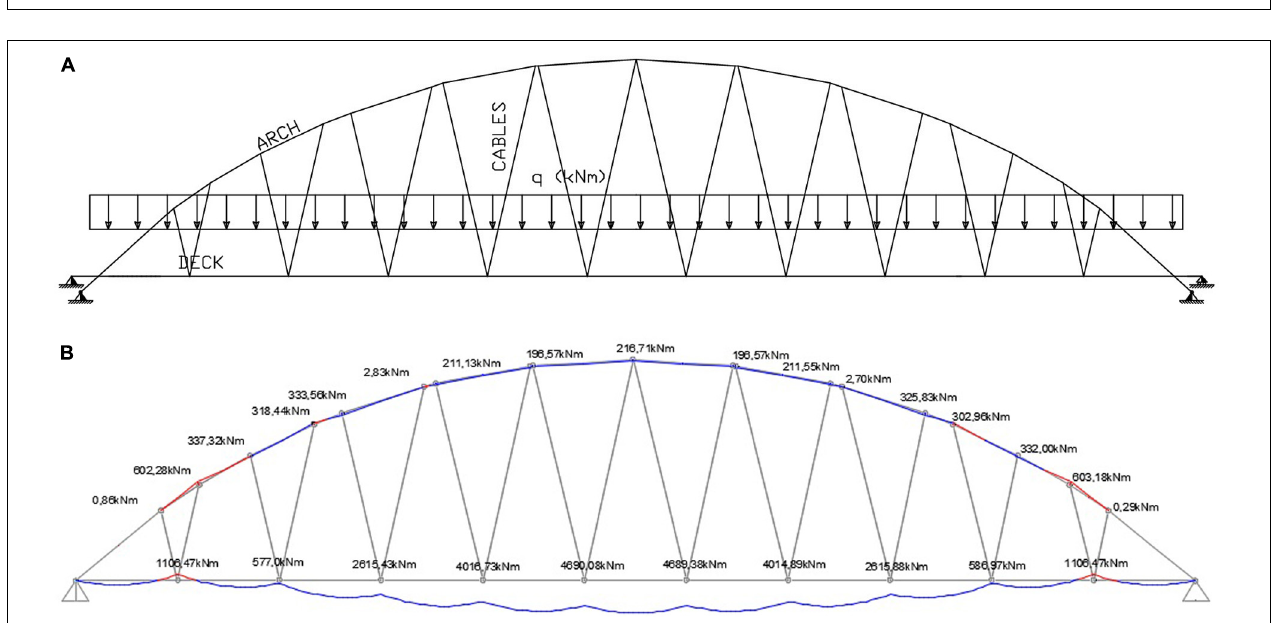
FIGURE 4 | Diagrams of the axial forces acting in all the cables when a selected cable is subject to a unit pre-tension. (A) Effects of a unit pre-tension of cable # 1. (B) Effects of a unit pre-tension of cable # 3. (C) Effects of a unit pre-tension of cable # 5. (D) Effects of a unit pre-tension of cable # 7. (E) Effects of a unit pre-tension of cable # 9.